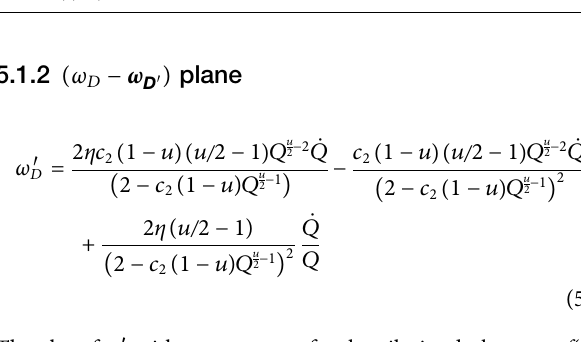
FIGURE 14 | Plot of r and s of pilgrim dark energy f ( Q ) gravity model versus redshift for the appropriate choice of